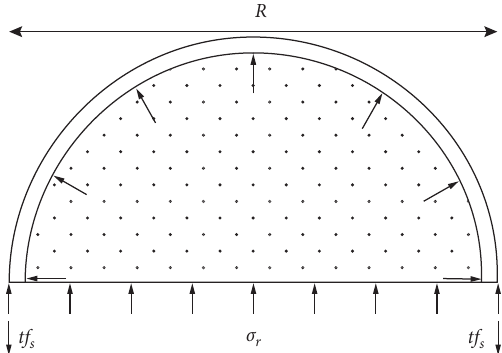
Figure 26: Internal force diagram of turntable